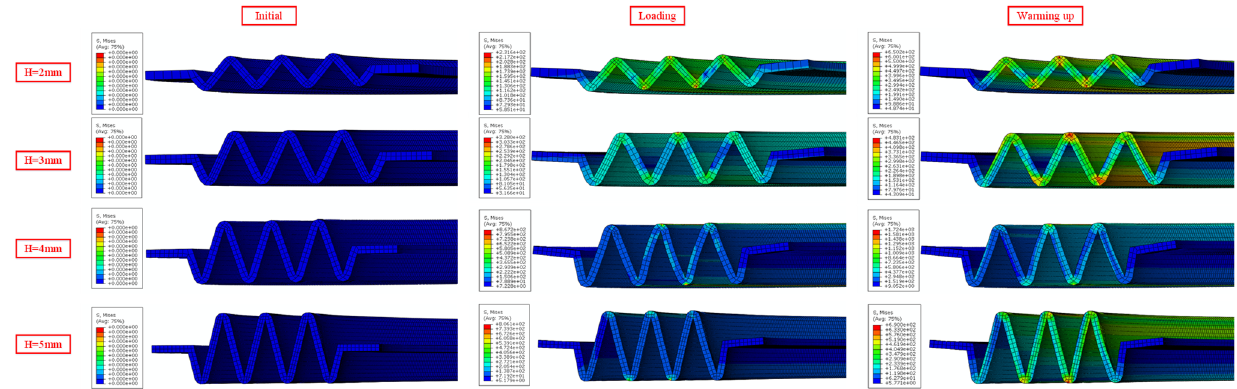
Figure 13. Relationship between contact stress and gasket height of NiTi alloy corrugated gasket.